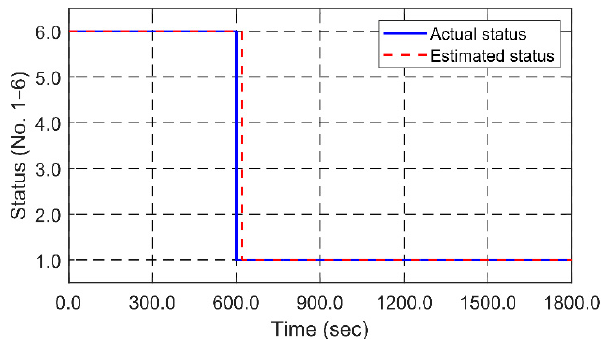
Figure 20. Time histories of failure detection status when both mooring lines in the middle location (Y = 0 m) are broken after 600 s ( H s = 2.5 m, T p = 7.5 s, current velocity = 0.6 m/s). Status 1 indicates the Output 1 case.